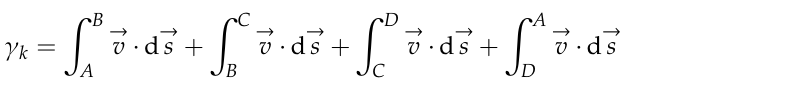
Figure 3. Illustration of the distributed vortices on an airfoil: ( a ) vortices; ( b ) viscous flow on a small